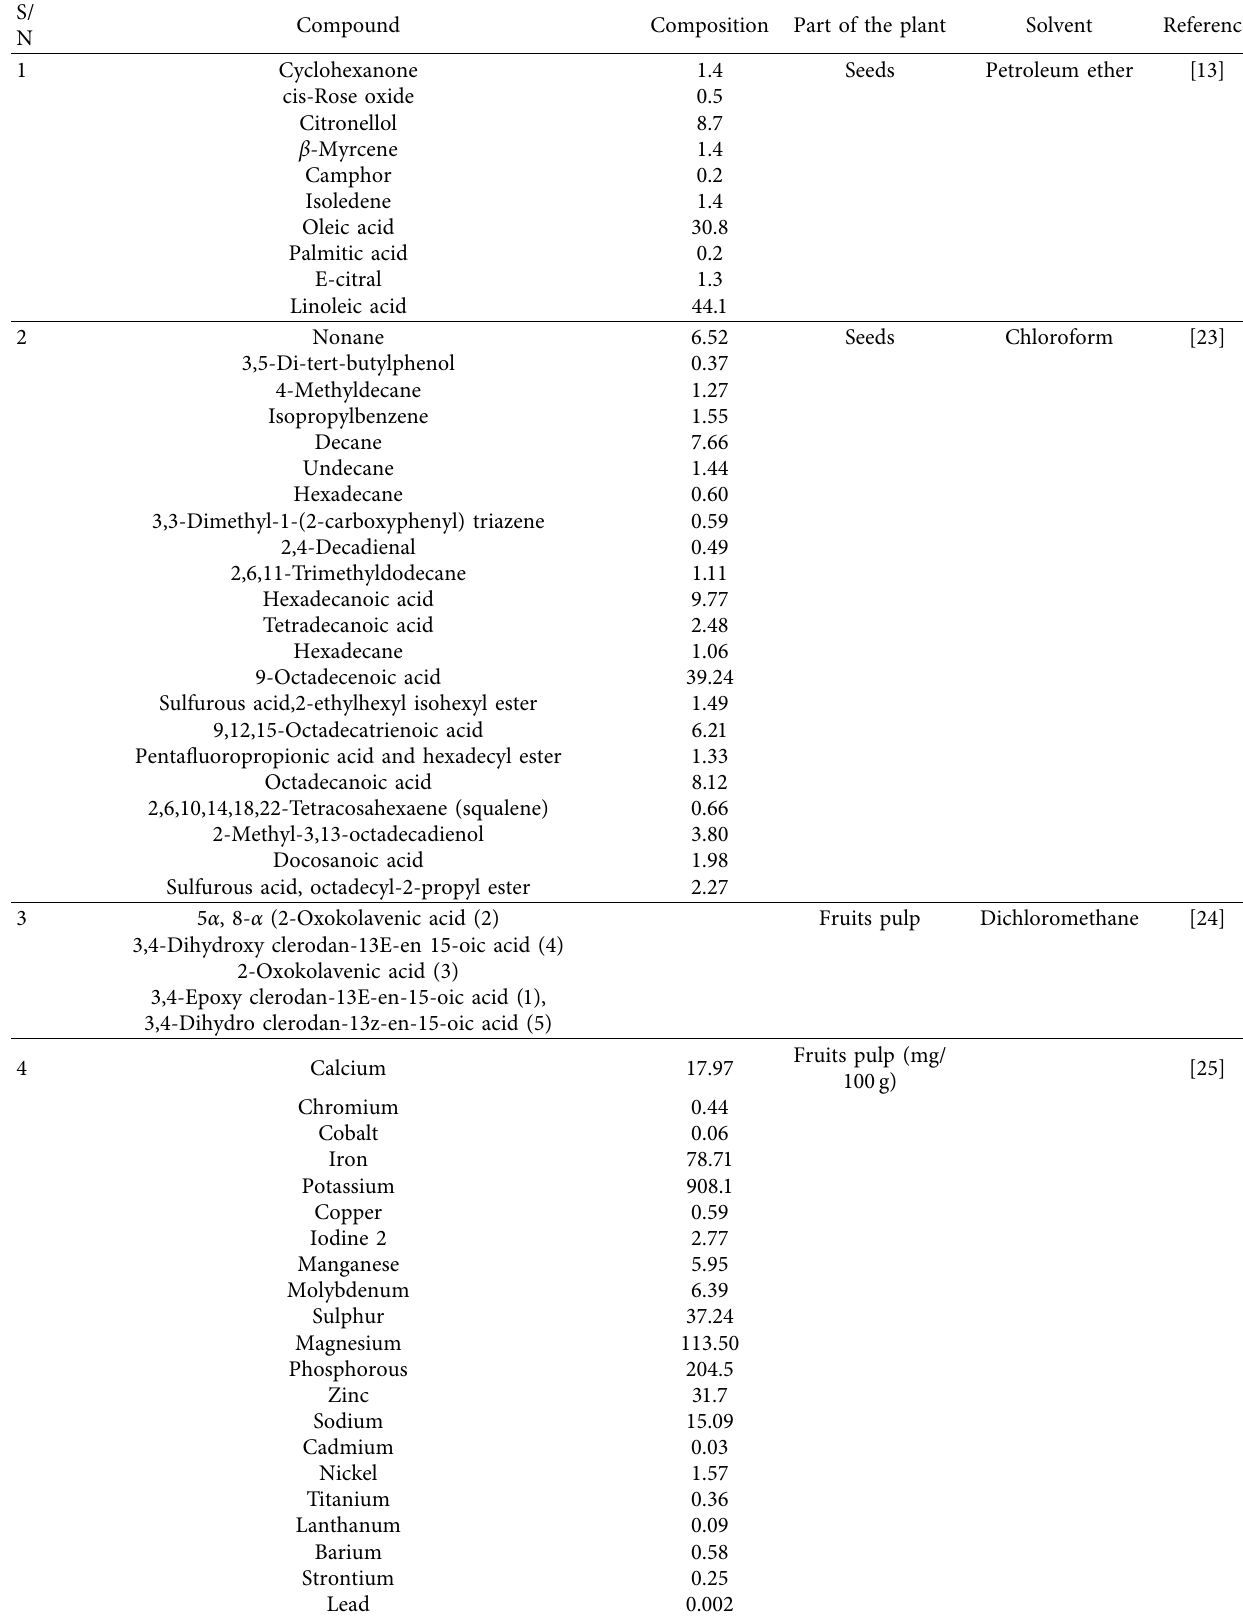
Table 1: Chemical composition of Detarium microcarpum